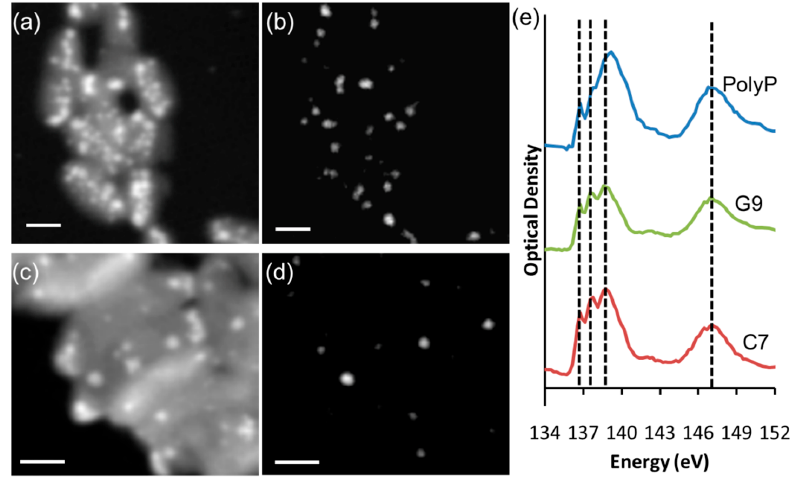
Figure 3. ( a ) STXM image at 136 eV of Ca . G. lithophora C7 cells grown in BG-11. ( b ) Corresponding map of phosphorus compounds absorbing at 136 eV (same area as in ( a )). The map was obtained by subtracting an image at 132 eV from an image at 136 eV. Pixel size is 50 nm; ( c ) STXM image at 132 eV of Ca . S. calcipolaris G9 cells grown in BG-11; ( d ) Corresponding map of phosphorus compounds absorbing at 138 eV (same area). The map was obtained by subtracting an image at 132 eV from an image at 138 eV. Pixel size is 70 nm; ( e ) XANES spectra at the P L 2,3 -edges of reference polyphosphates (top), P-rich inclusions of G9 cells shown in ( c ) (middle), P-rich inclusions of C7 cells shown in ( a ) (bottom). Vertical lines are located at 136.7, 137.7, 139 and 146.8 eV. Scale bar is 1 µm for all images.